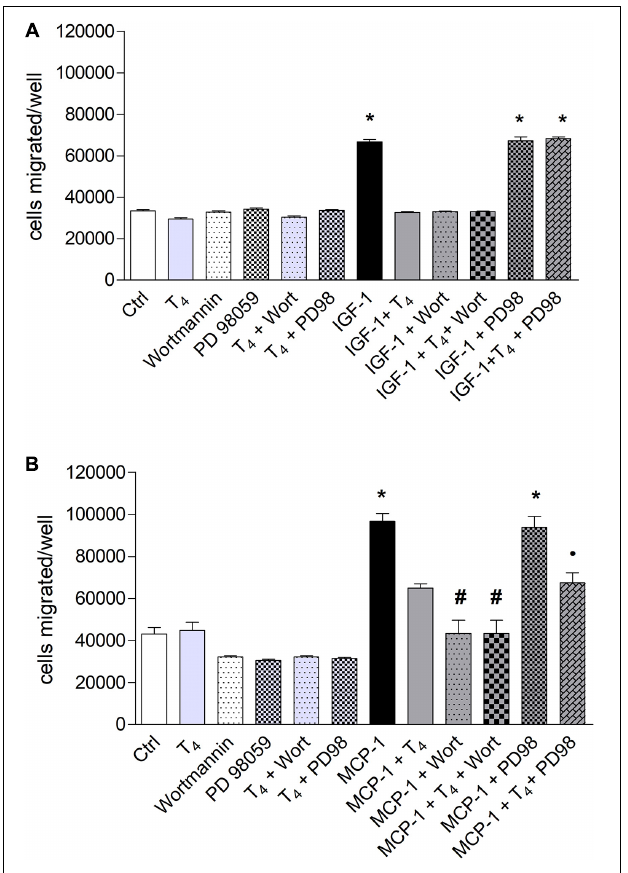
FIGURE 4 | Effect of T 4 on the migration of THP-1 cells induced by either insulin-like growth factor-1 (IGF-1) (A) or monocyte chemoattractant protein 1 (MCP-1) (B) . Possible role of mitogen-activated protein kinase (MAPK) and phosphoinositide 3-kinase (PI3K) pathways. (A) PD98059 (10 µ M) and wortmannin (100 nM) were preincubated 20 min before the addition of T 4 (10 − 7 M) and IGF-1 (10 − 8 M). Results are reported as mean ± SD of n = 3 different experiments carried out in duplicate. * p < 0.001 vs. all others. (B) PD98059 (10 µ M) and wortmannin (100 nM) were preincubated 20 min before adding T 4 (10 − 7 M) and MCP-1 (100 ng/ml). Results are reported as mean ± SD of n = 4 different experiments carried out in duplicate. * p < 0.001